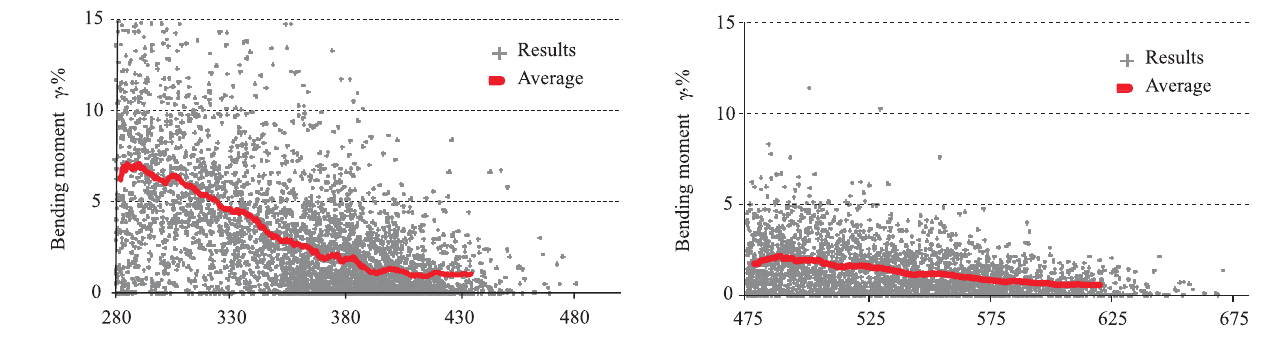
Fig. 11. Average DAF values for 7.5 m span bridge, subdivided into different vehicle fleets and meeting events (class B and no